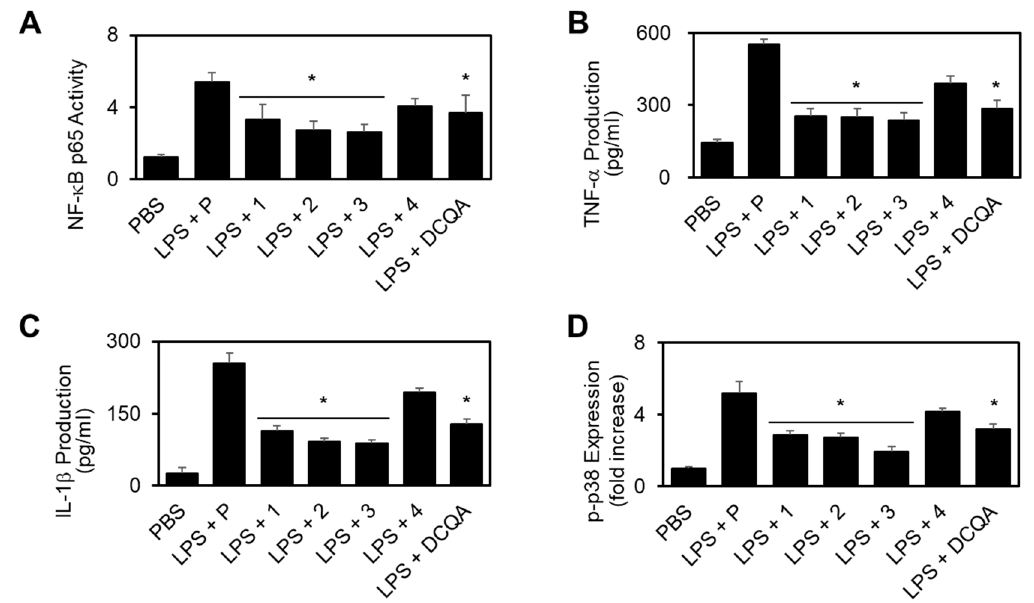
Figure 4. Effect of new compounds ( 1 – 4 ) on the LPS-stimulated activation of nuclear factor- κ B (NF- κ B), the production of tumor necrosis factor- α (TNF- α )/ interleukin-1 β (IL-1 β ), and the phosphorylation of p38 mitogen-activated protein kinase (MAPK). First, 20 µM of 3-5-di- O -dihydrocaffeoylquinic acid (DCQA) was used as positive control. ( A ) LPS (100 ng/mL)-mediated activation of NF- κ B p65 in HUVECs was analyzed after the treatment of cells with 10 µM of each compound for 6 h; LPS (100 ng/mL)-mediated production of TNF- α ( B ) or IL-6 ( C ) in HUVECs was analyzed after the treatment of cells with the indicated concentrations of each compound for 6 h; ( D ) HUVECs were activated with LPS (100 ng/mL), followed by treatment with each compound at different concentrations for 6 h. The effects of each compound on the LPS-mediated expression of phospho-p38 were determined by ELISA. * p < 0.05 vs. LPS.